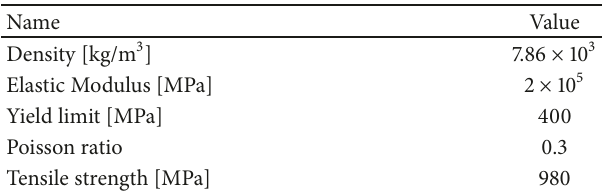
Table 8: Material parameters of main